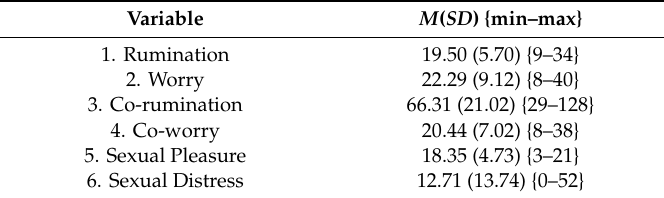
Table 2. Descriptive statistics for variables in the study ( n =